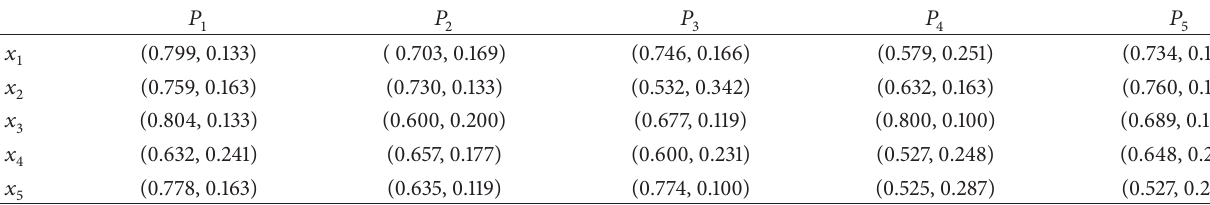
Table 5: Intuitionistic fuzzy decision matrix 𝑅 .